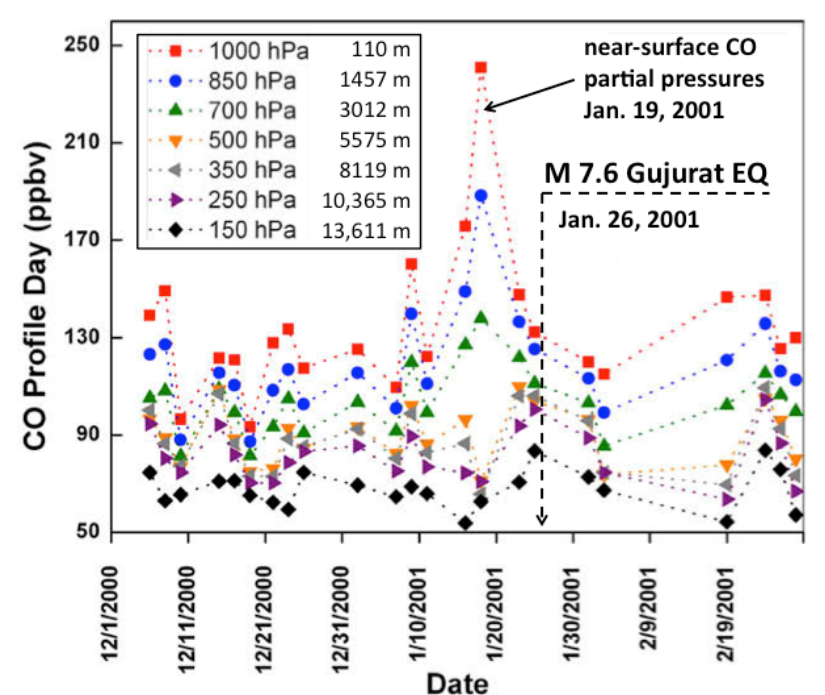
Figure 2. CO concentration values representing averages for a 1° × 1° area (approximately 100 × 100 km 2 ) around the epicenter of the Gujurat earthquake of January 26, 2001. The CO profile is broken down into the 7 altitude windows indicated in the